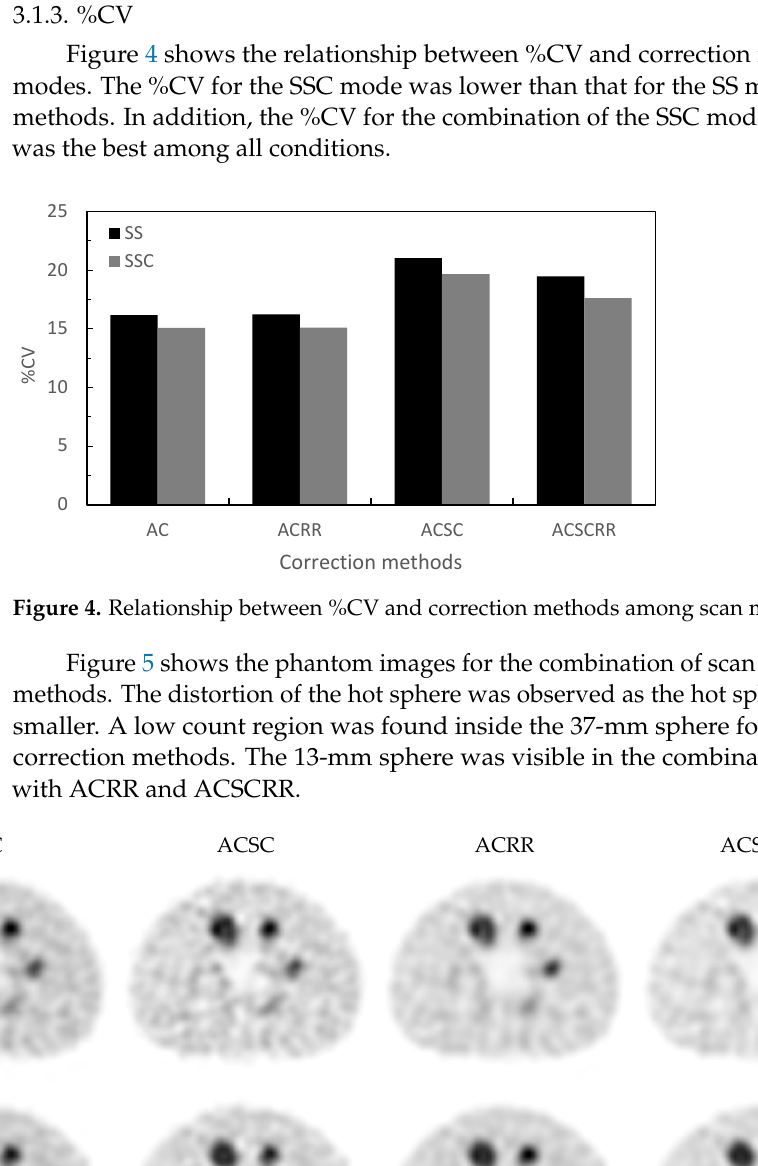
Table 3. Comparison of absolute error of the CNR between the SS and SSC modes.